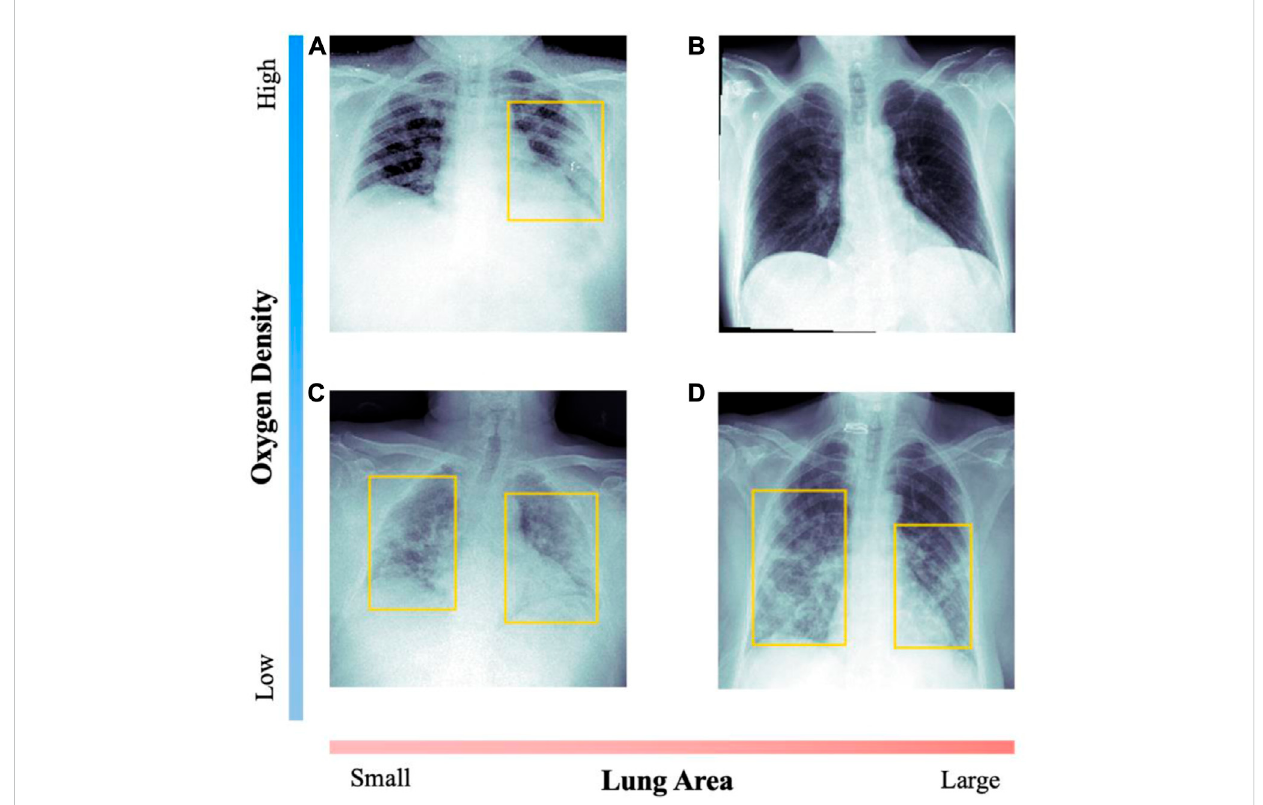
FIGURE 2 Comparisonofradiographswithopposedvaluesonthediagnosisvariables.Foreachimage,thepatient ’ sdataisincluded.Yellowboxesindicatelung opacity detection.Image (A) correspondsto a47-year-old woman, withmedium saturation; (B) toa53-year-oldman withadequatesaturation; (C) toan 82-year-old man with extreme saturation; (D) to a 72-year-old woman with low